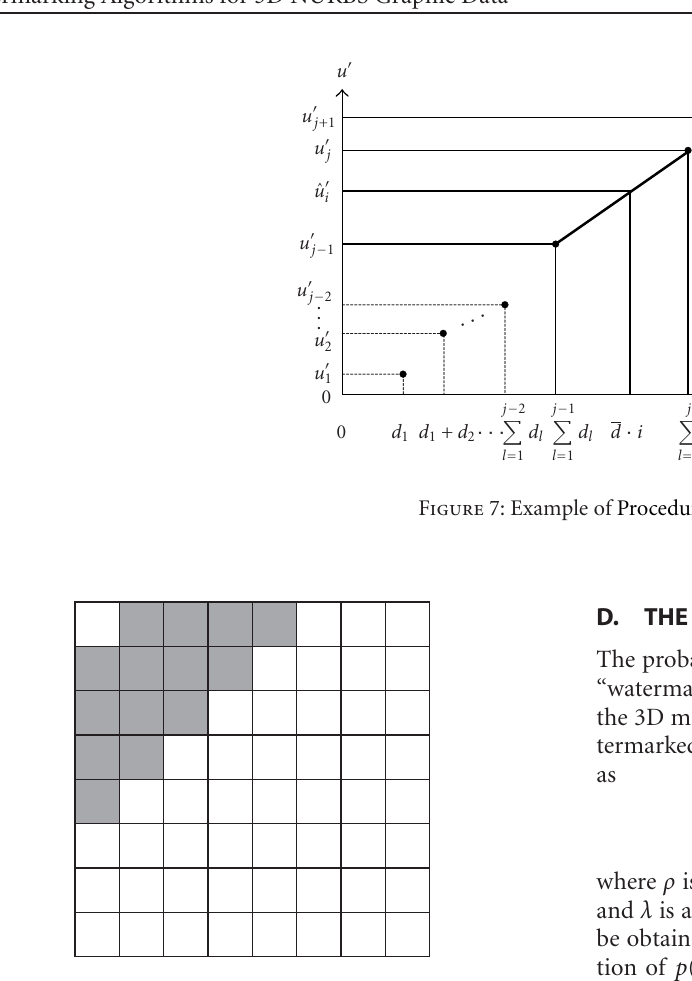
Figure 8: AC components where the watermark is